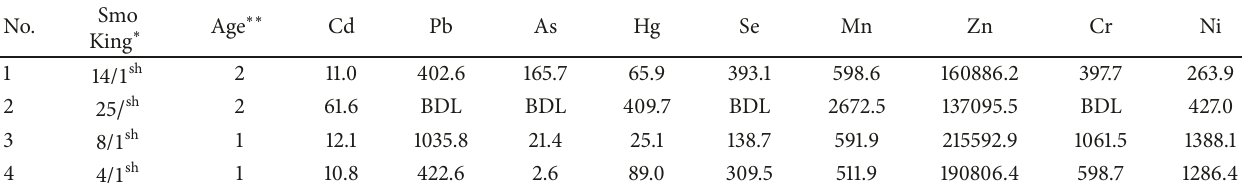
∗ Smoking; period of smoking (y)/rate of smoking (number of pipes per day), ∗∗ Age; 1= ≤ 25, 2= 26-40 y